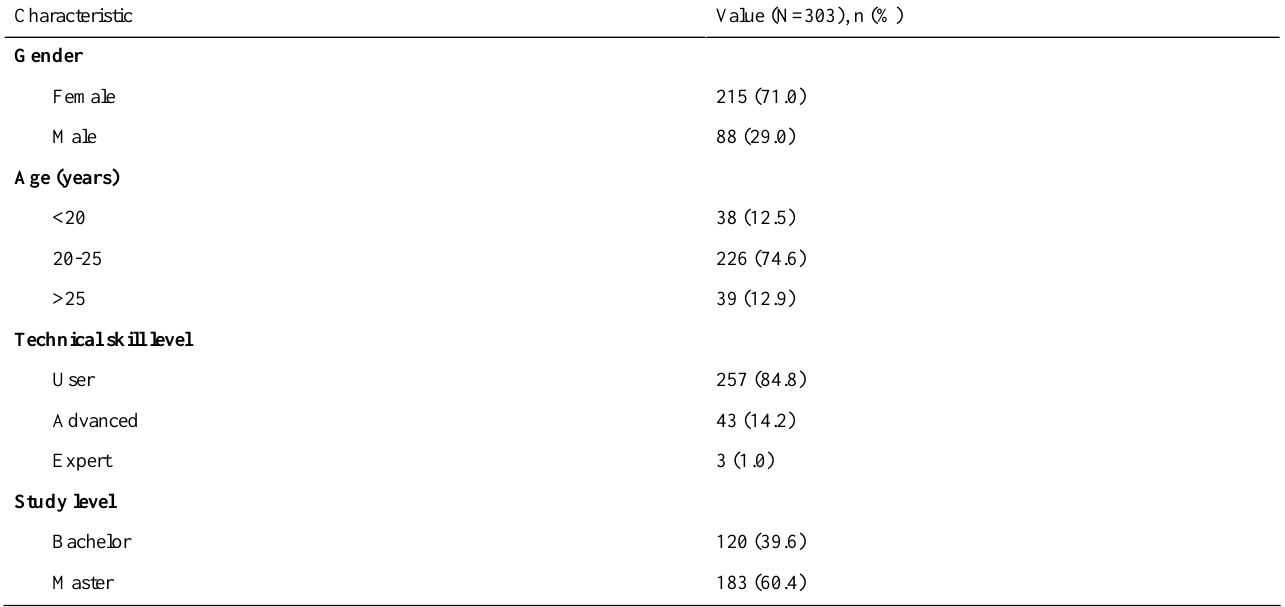
Table 1. Participant